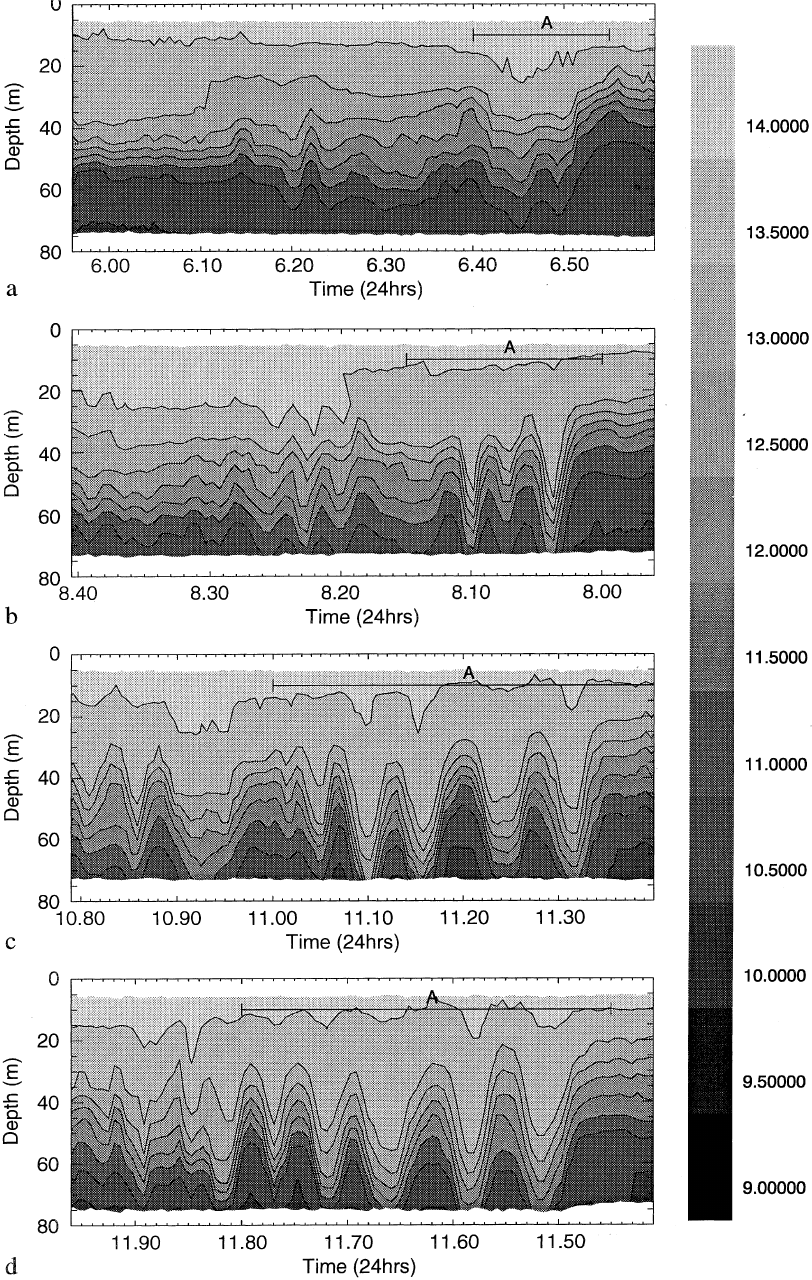
Fig. 4a–d. Close up temperature ( (cid:176) C) cros-sec- tions across the feature ‘ A ’ in the four surveys, as a function of time, but with the second and fourth survey reversed to show similar orienta- tions of the wave packet for all